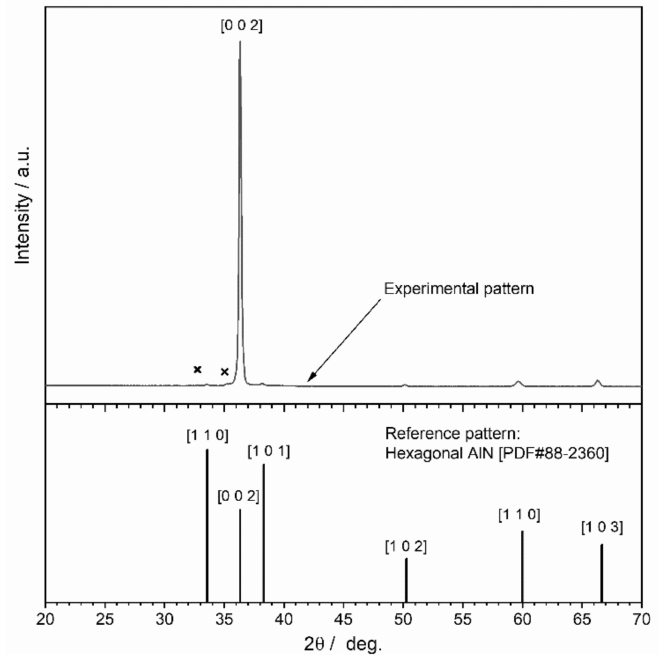
Figure 4. XRD data on substrate # 3 at nitrogen concentration of 0.8.